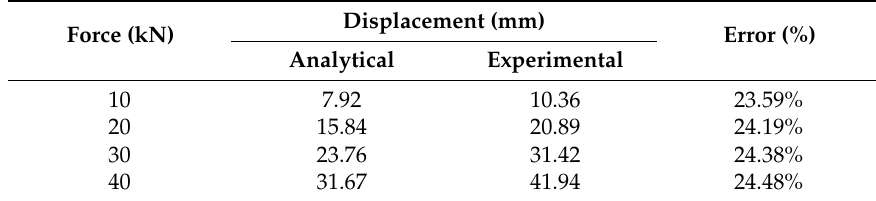
Table 5. Comparison of the experimental values obtained for the displacement of the wall with the ones predicted by the analytical model.